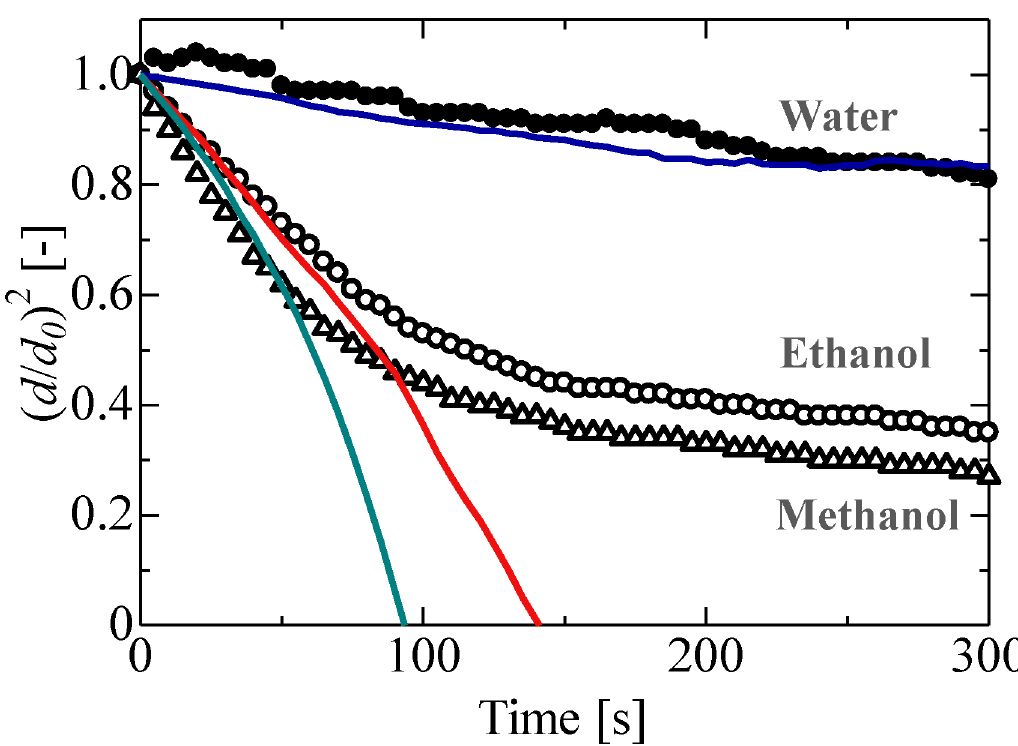
Fig 5. Comparison of theoretical and experimental ( d / d 0 ) 2 value evolution with time. Theoretical values calculated using the d 2 law are indicated by blue (water) red (ethanol), and green (methanol) solid line.